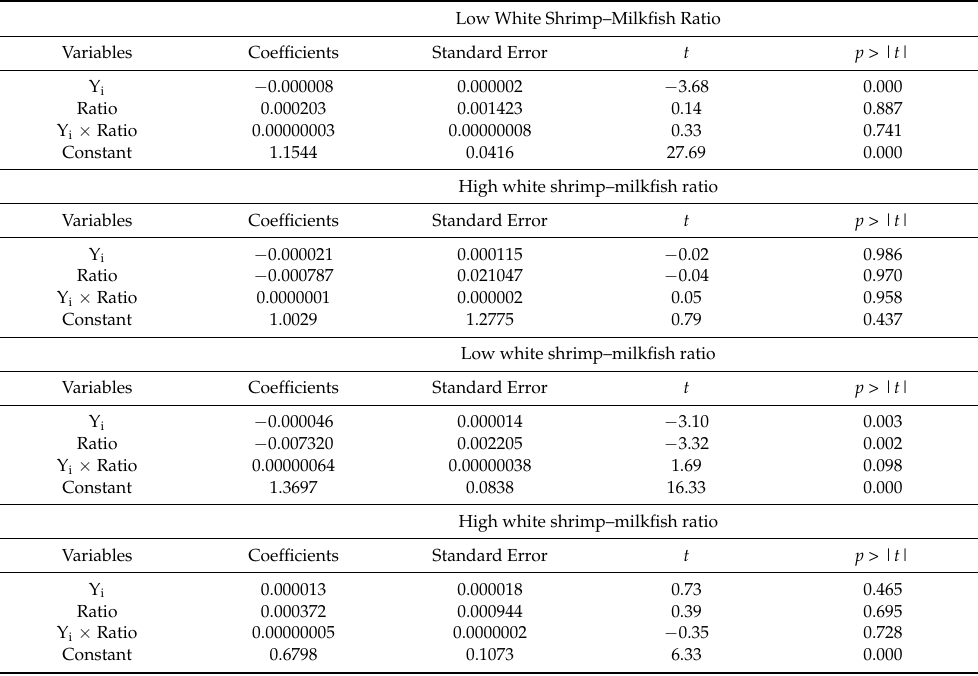
Table 6. Estimation result of robust linear regression between milkfish production outputs, white shrimp–milkfish fry stocking density ratio, and milkfish specific scale efficiency of the observed farming household